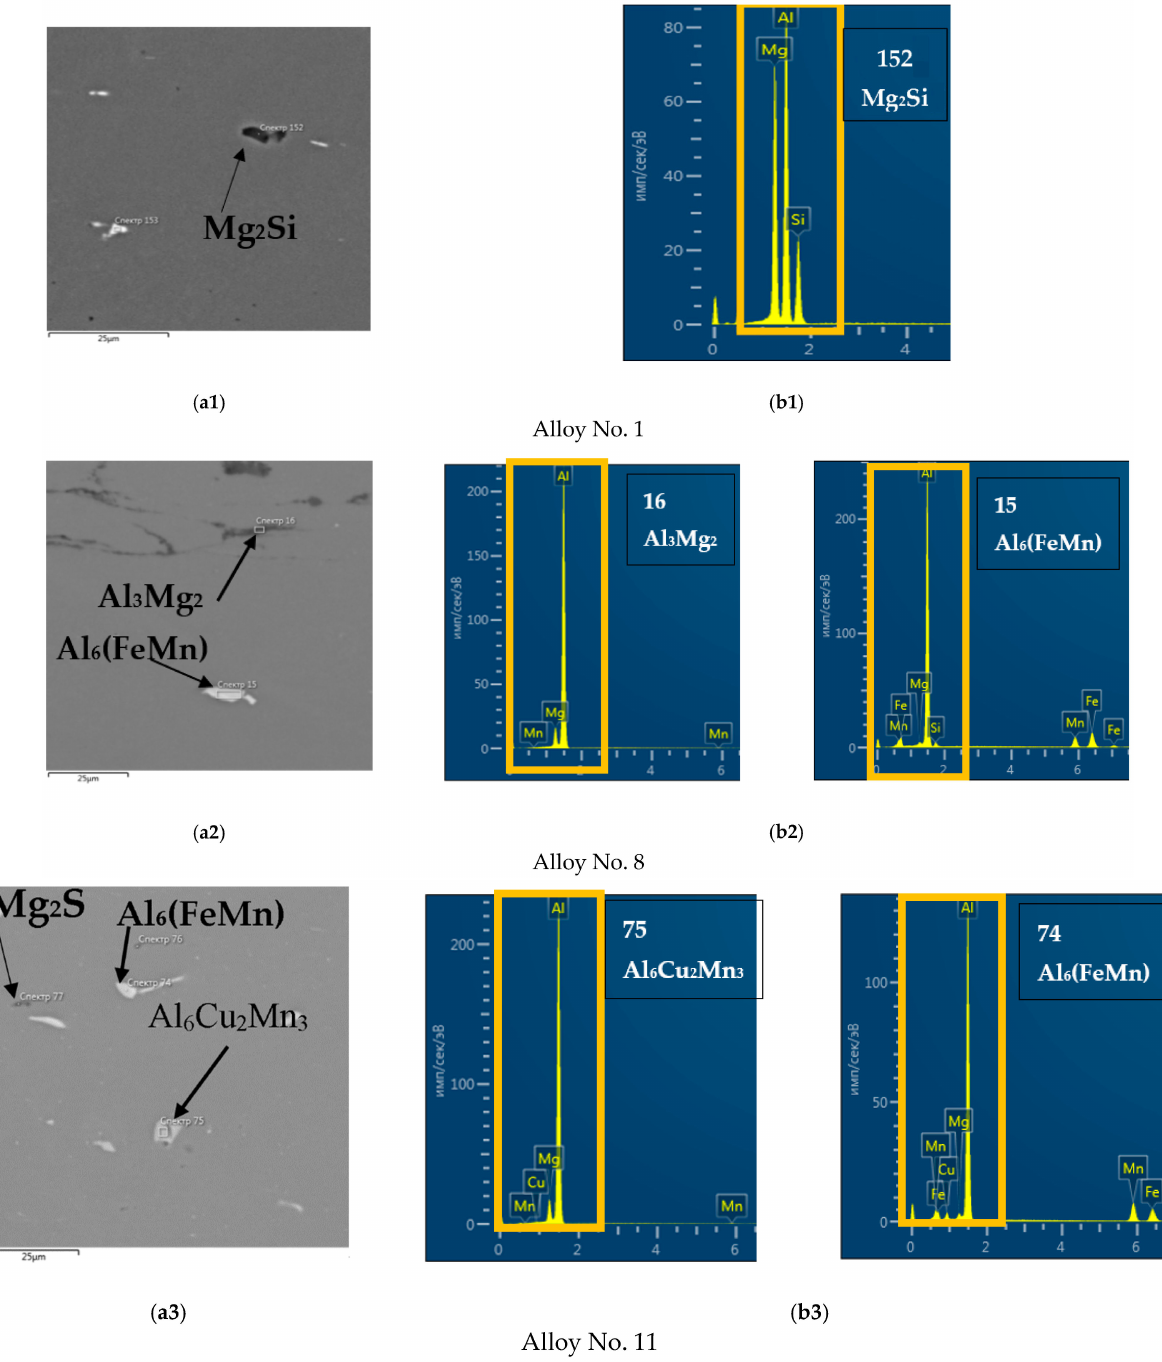
Figure 7. The types of intermetallic compounds ( a1 – a3 ); result of the EDS analyses ( b1 – b3